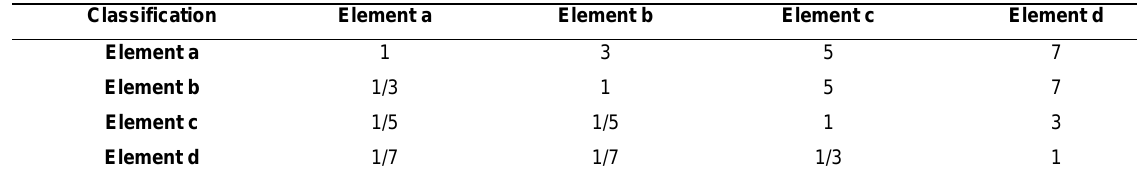
Table 3. Pairwise compression matrix